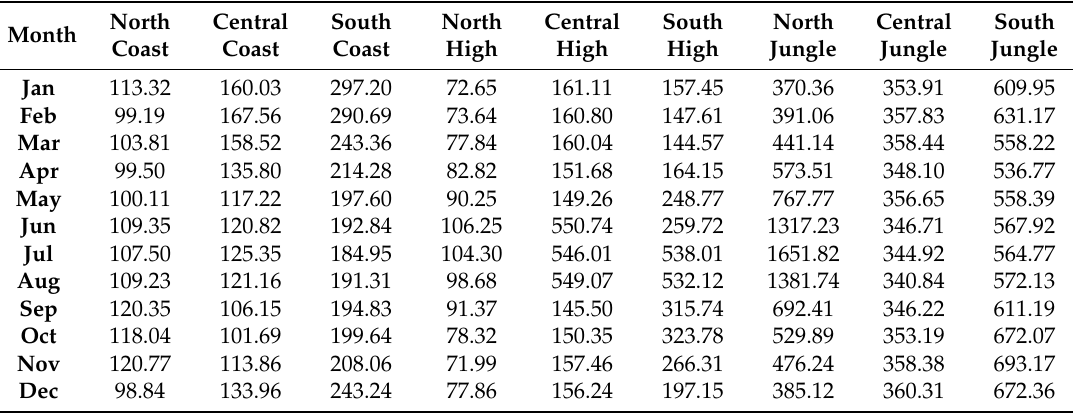
Table 4. Range values (in km) for the omnidirectional semivariogram analysis for each sub-region. Values obtained from the MODIS PWV